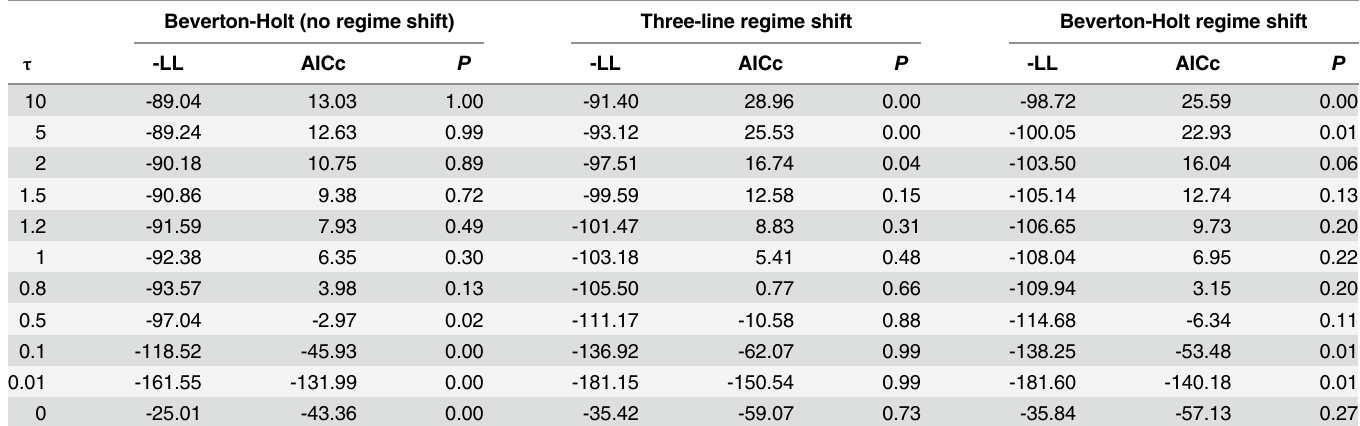
Table 3. Comparison of negative log-likelihoods and AICc between the Beverton-Holt, three-line regime shift and Beverton-Holt regime shift mod- els fitted to the spawning stock biomass and recruitment estimates from the 2014 assessment of western Atlantic bluefin tuna. Note that the AIC weights P were computed here by applying eq 13 to all three models.